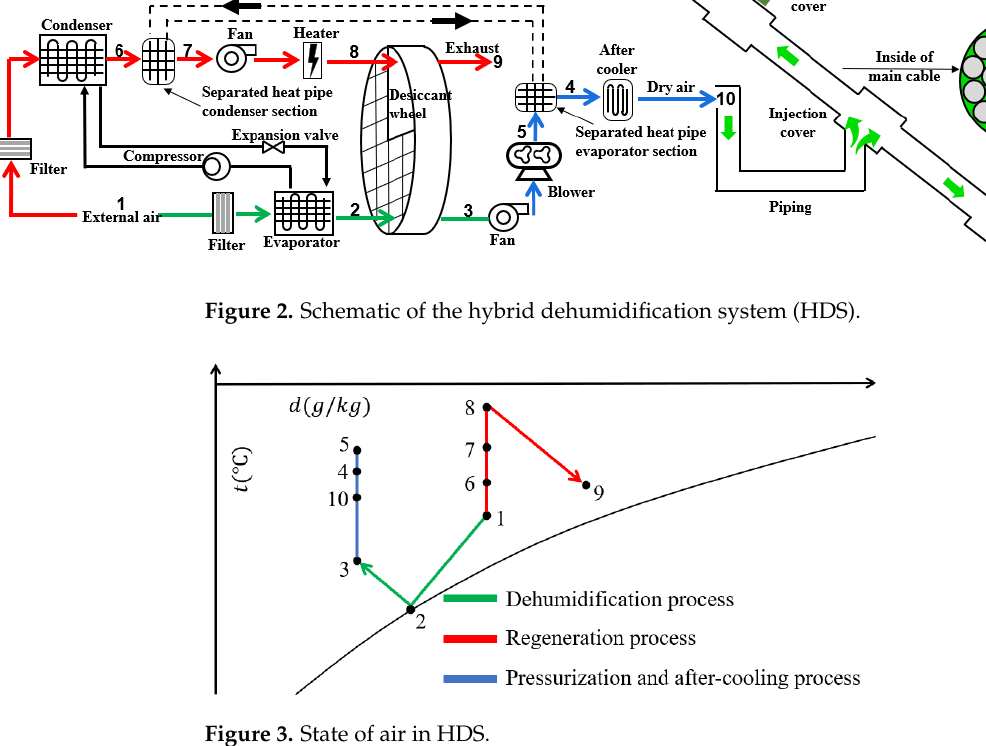
Figure 3. State of air in HDS.